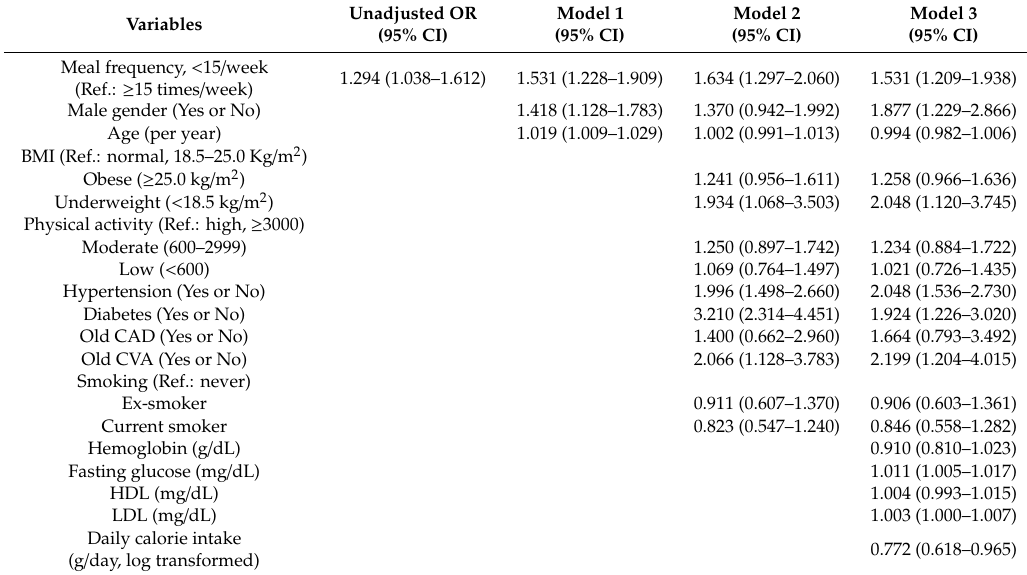
Table 2. The complex samples multivariate logistic regression for CKD by meal frequency.